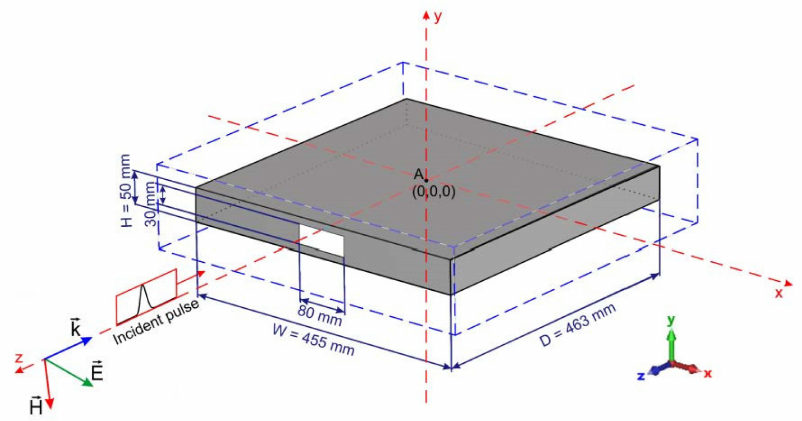
Figure 1. The geometry of the enclosure with aperture in the rectangular coordinate system. The computation area is marked in blue dashed lines. The electric field strength vector the +x direction. The magnetic strength vector propagation direction of the EM incident pulse. Point A is the center of the